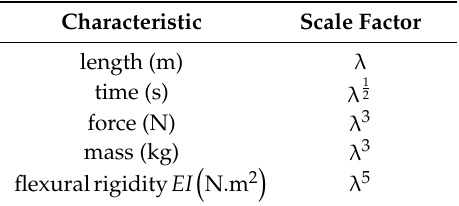
Table 1. Scale factors using Froude scaling.